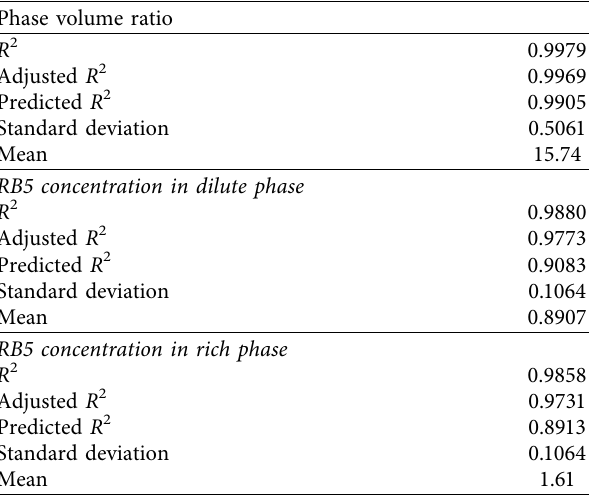
Table S2. Physical properties for 50 ppm of surfactant dilute phase and surfactant-rich phase at 313.15 K, 323.15 K, and 333.15 K. Table S3. Physical properties for